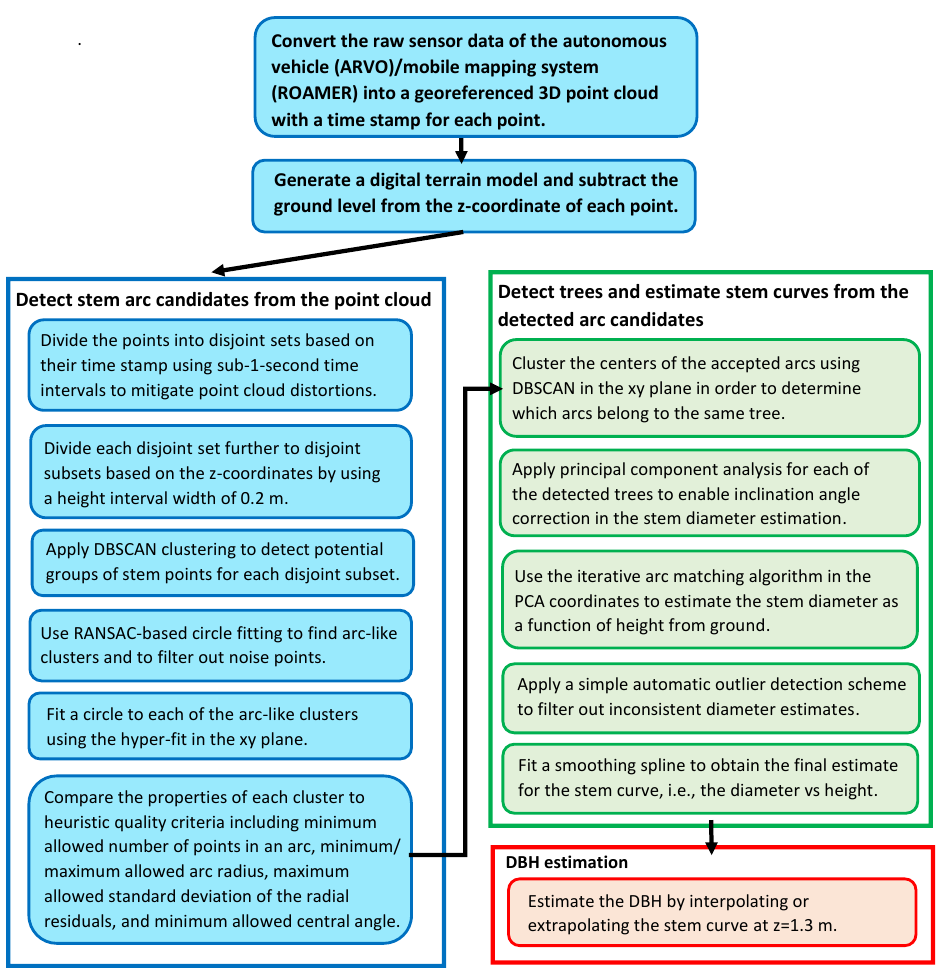
Figure 5. Flow chart of the data processing steps utilized to detect roadside trees and to estimate their stem curves and